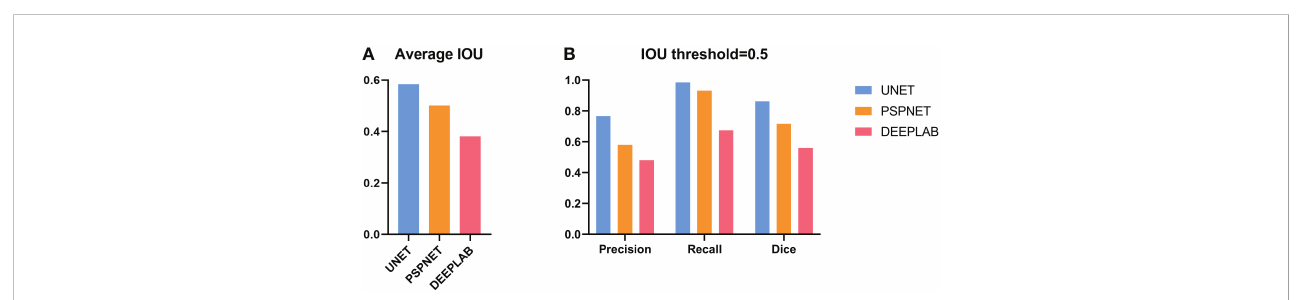
FIGURE 6 Performance of CNN2 and other deep models on the test set. (A) The average IOU compared between UNet, PSPNet and DeepLab. (B) The precision, recall and the Dice coef fi cient of UNet, PSPNet and DeepLab at the IOU threshold of 0.5. CNN, convolutional neural network. IOU, Intersection over union.